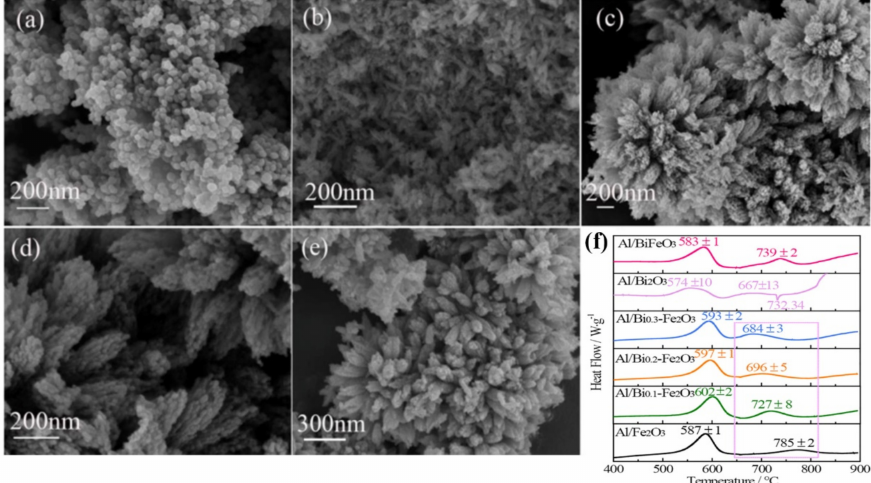
Figure 27. SEM images of ( a ) Fe 2 O 3 and ( b ) Bi 0 . 1 -Fe 2 O 3 ; ( c , d ) low and high magnification images of Bi 0 . 2 -Fe 2 O 3 ; ( e ) SEM image of Bi 0 . 3 -Fe 2 O 3 ; ( f ) DSC curve of six thermites obtained with a heating rate of 10 ◦ C · min − 1 under N 2 flow. ( a – f ) Reproduced with the permission of ref. [134]. Copyright 2021, Chemical Engineering Journal.